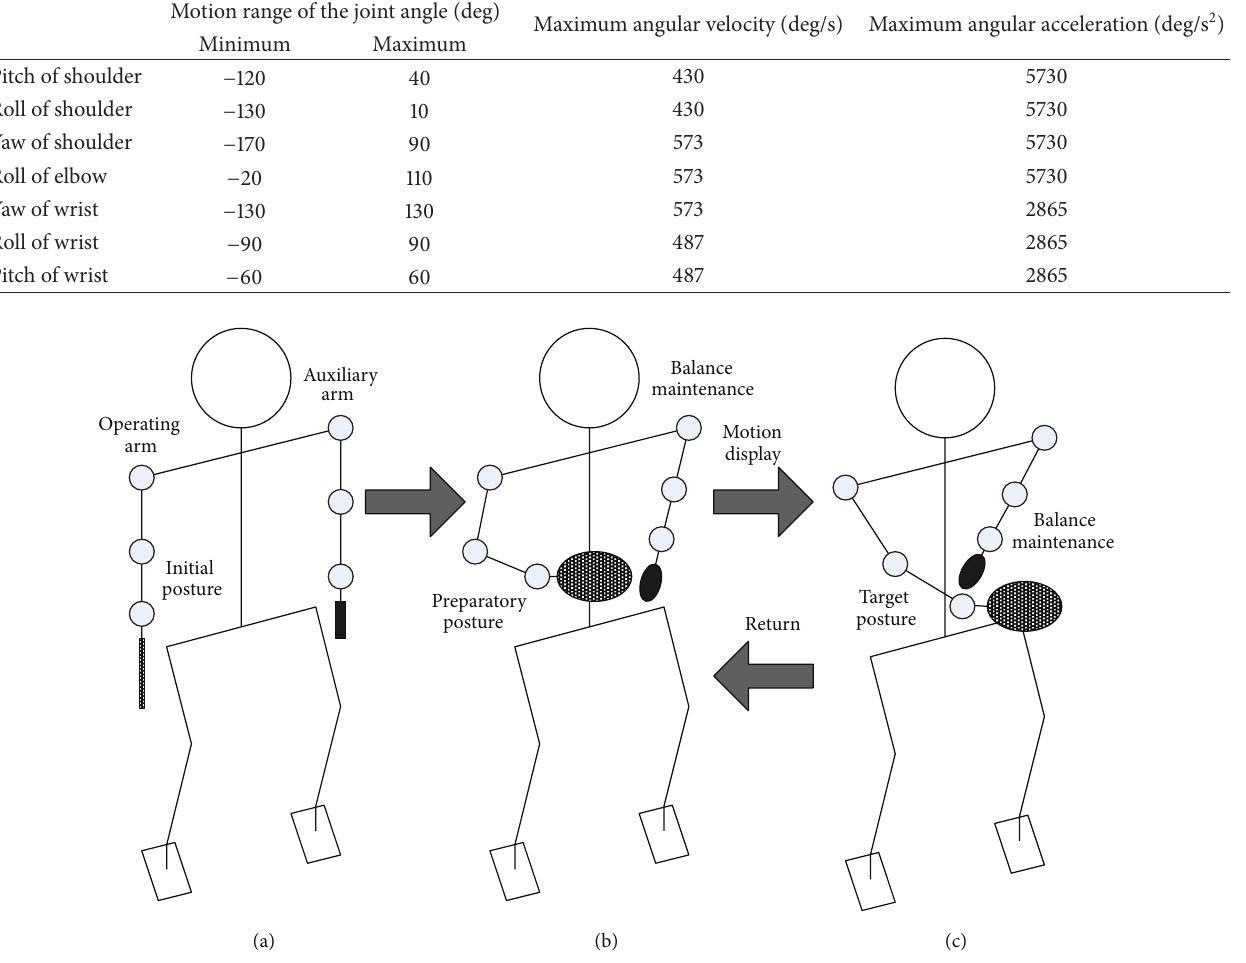
Figure 4: Operation and balance maintenance processing of the humanoid